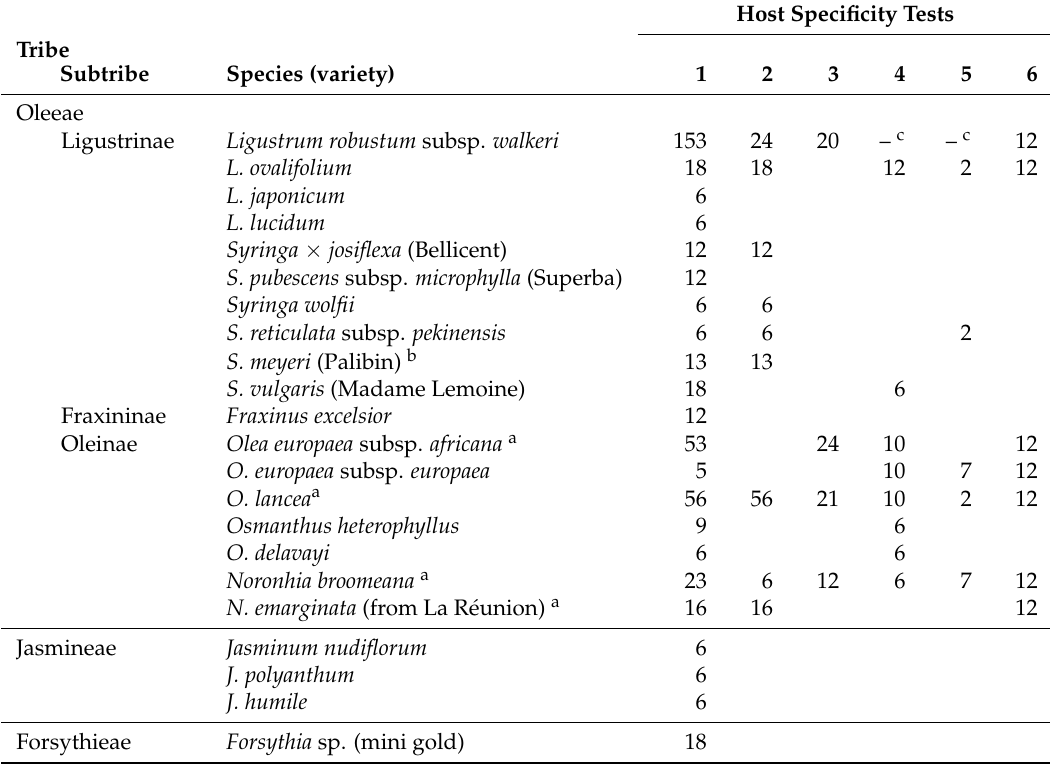
Table 1. Oleaceae test plants for Epiplema albida indicating which species were used in what numbers in each test: (1) larval no-choice feeding test, (2) larval development tests on excised foliage, (3) larval development tests on potted plants, (4) larval choice-tests, (5) single-choice oviposition tests, and (6) multiple-choice oviposition tests. Nomenclature has been checked against Tropicos [25] and The Plant List [13], and classification is based on Wallander